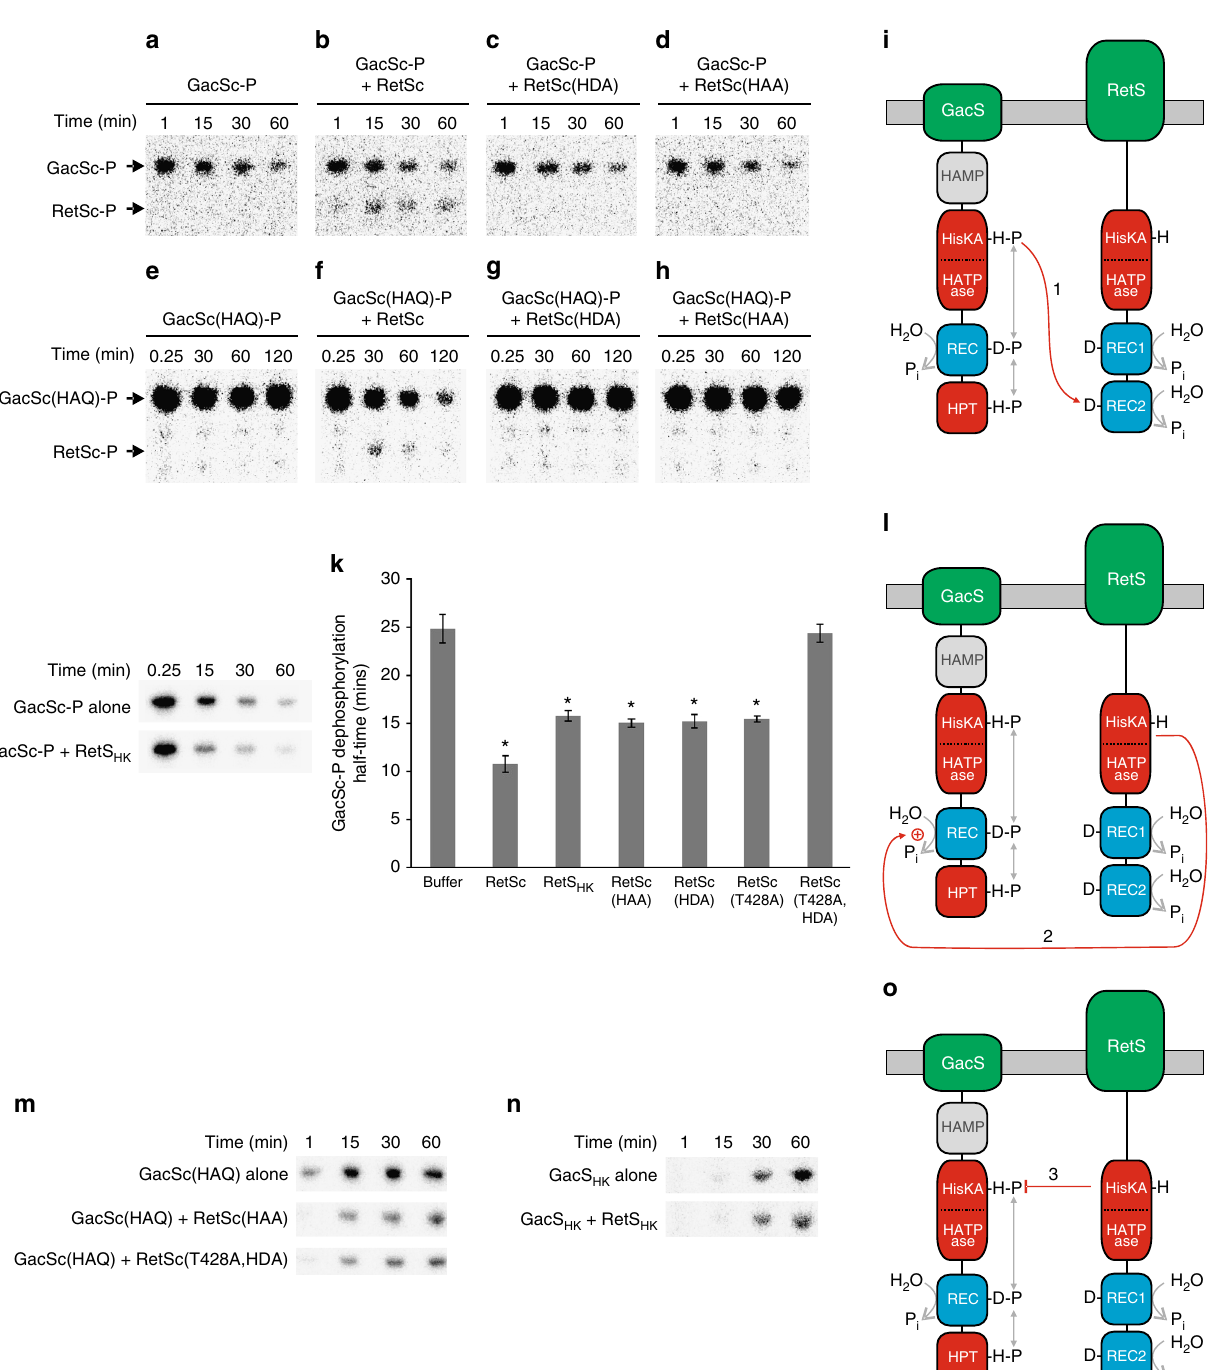
Fig. 1 RetS downregulates GacS signalling via three distinct mechanisms. a – i Mechanism 1 — RetS takes phosphoryl groups from GacS-P. Phosphorimages of SDS-PAGE gels showing phosphotransfer from a – d GacSc-P to a buffer control, b RetSc, c RetSc(HDA) and d RetSc(HAA), and from e – h GacSc(HAQ)-P to e buffer control, f RetSc, g RetSc(HDA) and h RetSc(HAA). Experiments were repeated fi ve times and a representative image shown. i Cartoon depicting mechanism 1, where phosphotransfer occurs from the His residue in the HisKA domain of GacS to D858 in REC2 of RetS. j – l Mechanism 2 — RetS has transmitter phosphatase activity against GacS-P. j Phosphorimages of SDS-PAGE gels measuring the dephosphorylation of GacSc-P alone (top) and with RetS HK (bottom). k GacS-P dephosphorylation half-times in the presence of various RetS mutant proteins. Error bars show SEM from eight replicates. *Signi fi cantly faster than GacSc-P autodephosphorylation ( P < 0.05, one-way ANOVA). l Cartoon depicting mechanism 2, where RetS uses transmitter phosphatase activity against the REC domain of GacS-P. m – o Mechanism 3 — RetS inhibits the GacS autophosphorylation reaction. Phosphorimages of SDS- PAGE gels comparing the autophosphorylation of: m GacSc(HAQ) on its own (top), with RetSc(HAA) (middle), and with RetSc(T428A,HDA) (bottom). n GacS HK on its own (top) and with RetS HK (bottom). Experiments were repeated eight times and a representative image shown. o Cartoon depicting mechanism 3, where the catalytic core of RetS blocks the autophosphorylation of